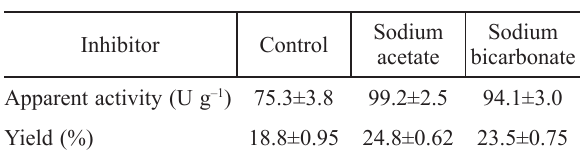
Table 1 – Immobilization of CCA in the presence of inhibi-